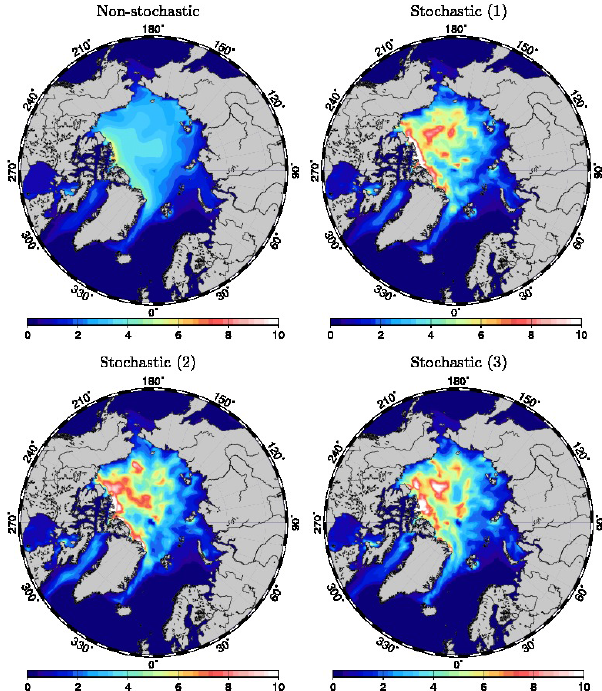
Figure 4. Sample of ice thickness patterns (in meters) in winter (end of March), illustrating the intrinsic interannual variability generated by the stochastic parameterization of ice strength in a low-resolution global ocean model (ORCA2). The top left panel represents the non- stochastic simulation, and the other panels are 3 different years of the stochastic